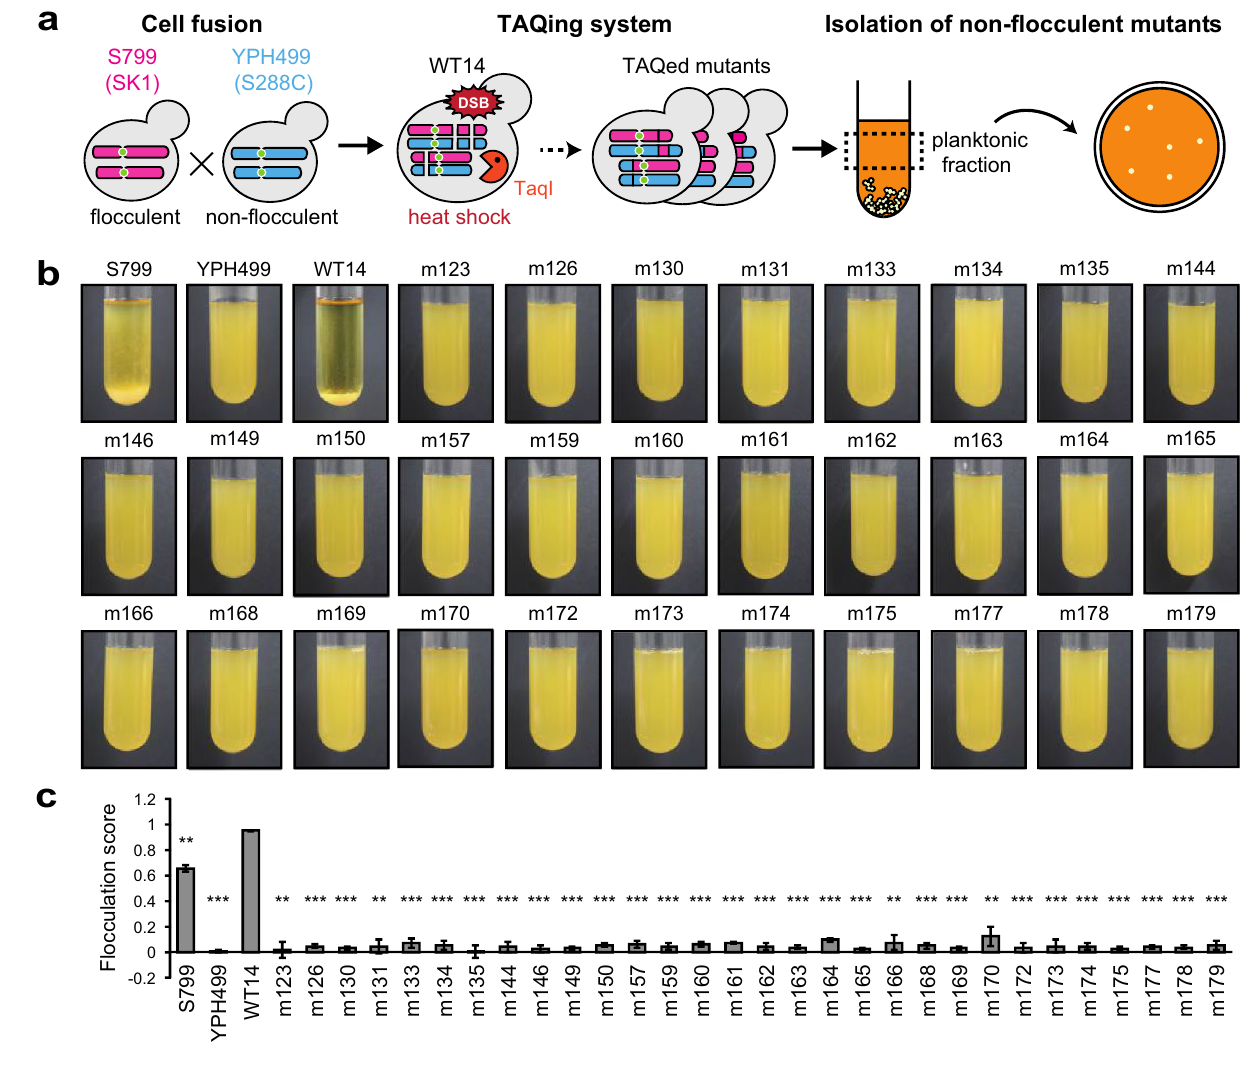
Figure 1. TAQing system alter flocculation phenotypes. ( a ) A schematic of the workflow to obtain non- flocculent phenotypes from flocculent strains. S. cerevisiae haploid strains flocculent S799 and non-flocculent YPH499 are cell-fused into diploids (WT14), followed by TAQing treatment. Heat-activated endonuclease TaqI introduces multiple DNA double-strand breaks, leading to large-scale genome rearrangement. Non- flocculent TAQed mutants are isolated by screening planktonic cells with the remaining culture supernatant. ( b ) Flocculation behaviors of parental strains (S799, YPH499, WT14) and TAQed mutants (m123, m126, m130, m131, m133, m134, m135, m144, m146, m149, m150, m157, m159, m160, m161, m162, m163, m164, m165, m166, m168, m169, m170, m172, m173, m174, m175, m177, m178, and m179). ( c ) Flocculation scores of parental strains and TAQed mutants. P values were calculated using the Welch’s t -test compared to WT14: ** P < 0.01 and *** P < 0.001. Error bars represent standard deviation ( n =